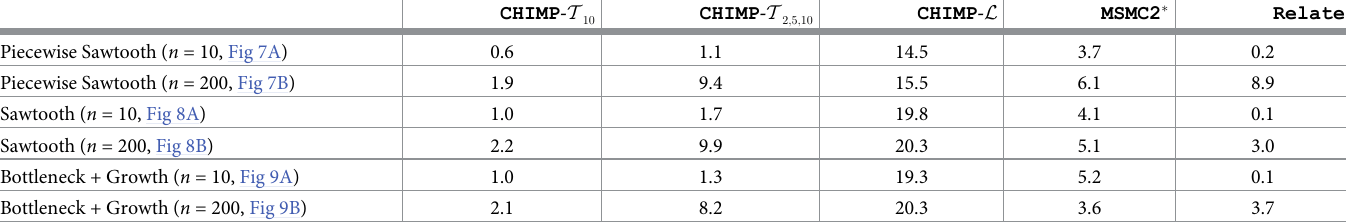
Table 3. Run-times in hours for the analysis of simulated data in the different scenarios, averaged over the respective 16 replicates in each case. The runtimes for MSMC2 are slightly inflated, as the number of CHMM states had to be increased to allow for the closest matching of demographic epochs. ( � ) For the n = 200 scenarios, MSMC2 was only run on 50 non-overlapping pairs of